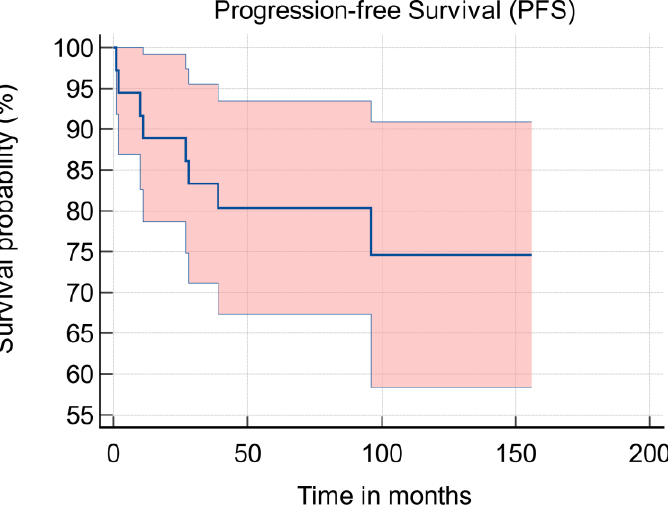
Figure 2. Kaplan-Meier progression free survival graph.